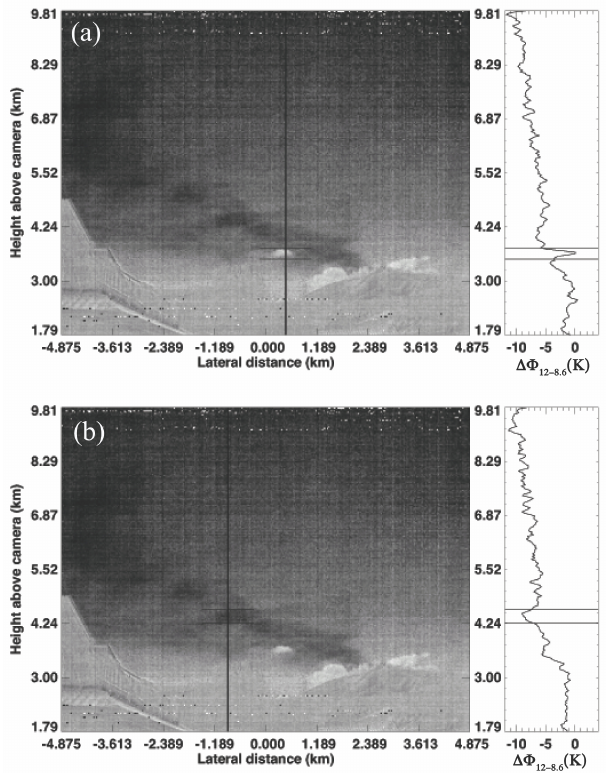
Figure 10. (a) 12–11µm brightness temperature difference ( 18 12 , 11 ) image of the Mt Etna plume. The panel to the right shows a temperature-difference–height profile for one image col- umn, indicated by the vertical line on the image. (b) As for (a) but for the temperature difference between the 12 and 8.6µm channels ( 18 12 , 8 . 6 ). The height profile for the same column as (a) is shown to the right of this image.